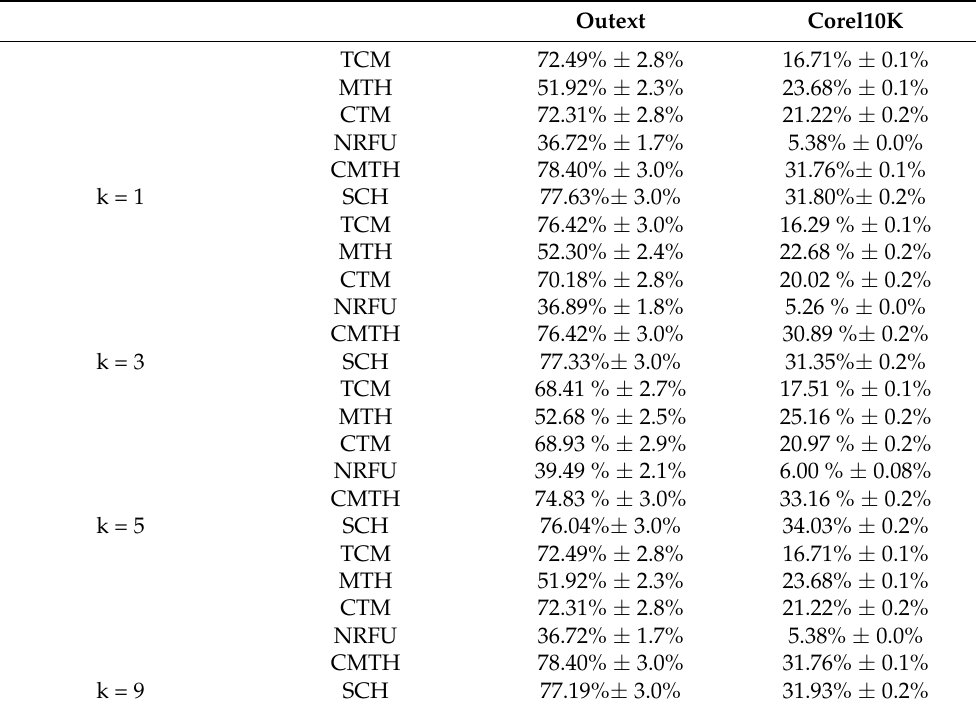
Table 7. Results of SCH together with texton-based features using different values of k (KNN’s